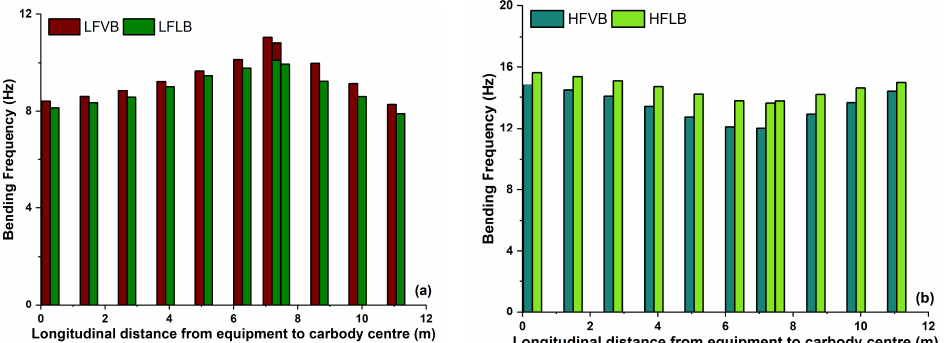
Figure 7. Association of bending frequency with the longitudinal distance from equipment to CB center. ( a ) LFVB ( b ) HFVB for elastically suspended equipment.